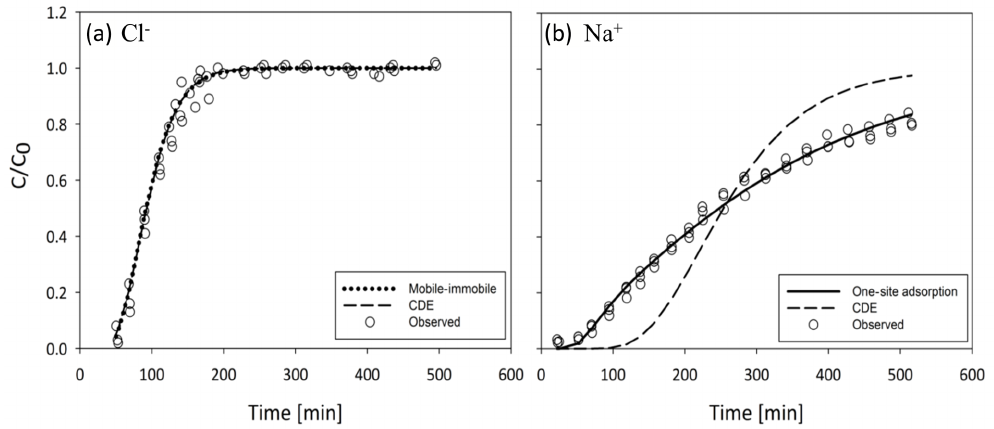
Figure 6. Breakthrough curves of observed values and fitted models of Cl − (a) and Na + (b) .